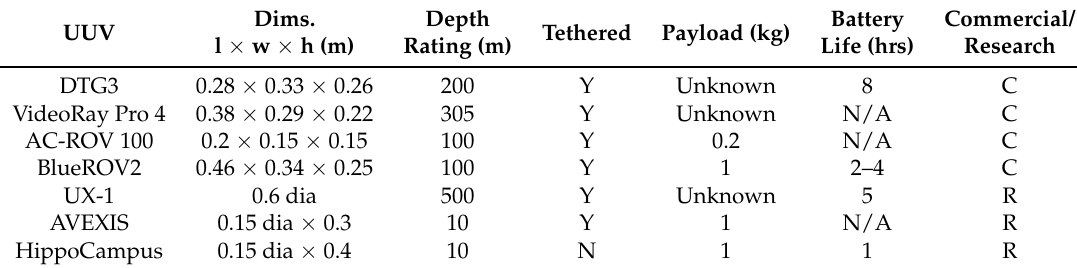
Figure 2. Unmanned underwater vehicles (UUVs): ( a ) BlueROV2 [38], ( b ) AVEXIS [19], and ( c ) HippoCampus [39]. Table 4. Characterisitcs of